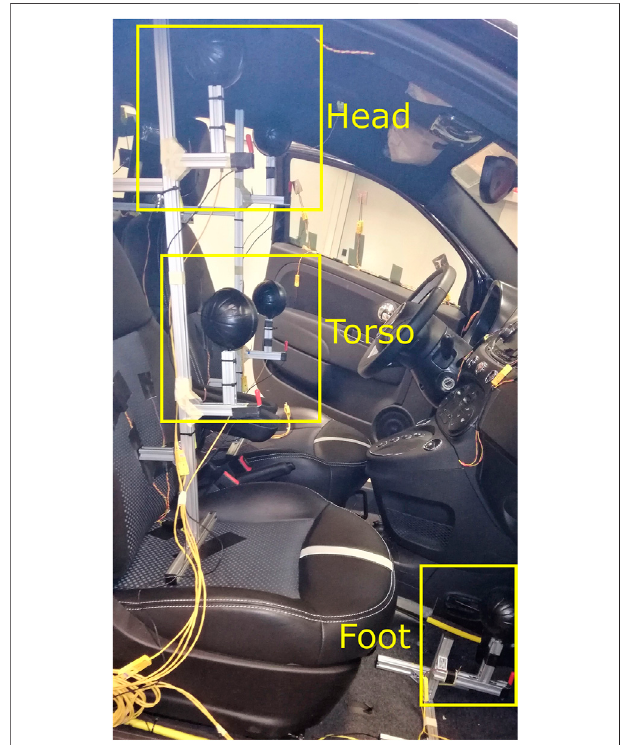
FIGURE 2 | Sensors at the head, torso, and foot